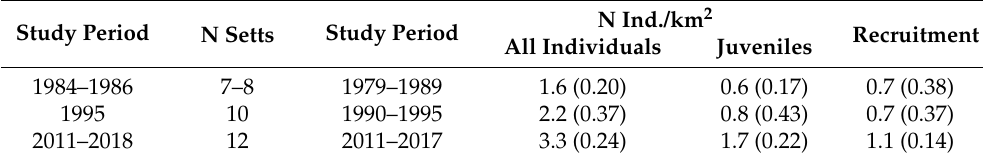
Table 4. Number of inhabited badger setts (including groups without cubs and solitary badgers), estimated (mean( ± SE)) density of badgers (adult and juveniles) in May/June calculated per forest area, and recruitment (N juveniles per N of adults) in the field and forest mosaic (Central Poland) in the three periods: data for the first two periods from Goszczy´nski and Skoczy´nska [3], and 2011–2018 (this study). To compare the absolute number of setts between periods we used only those years which encompassed the same study area. For other comparisons (density, recruitment), we used all available past data. Study Period Study